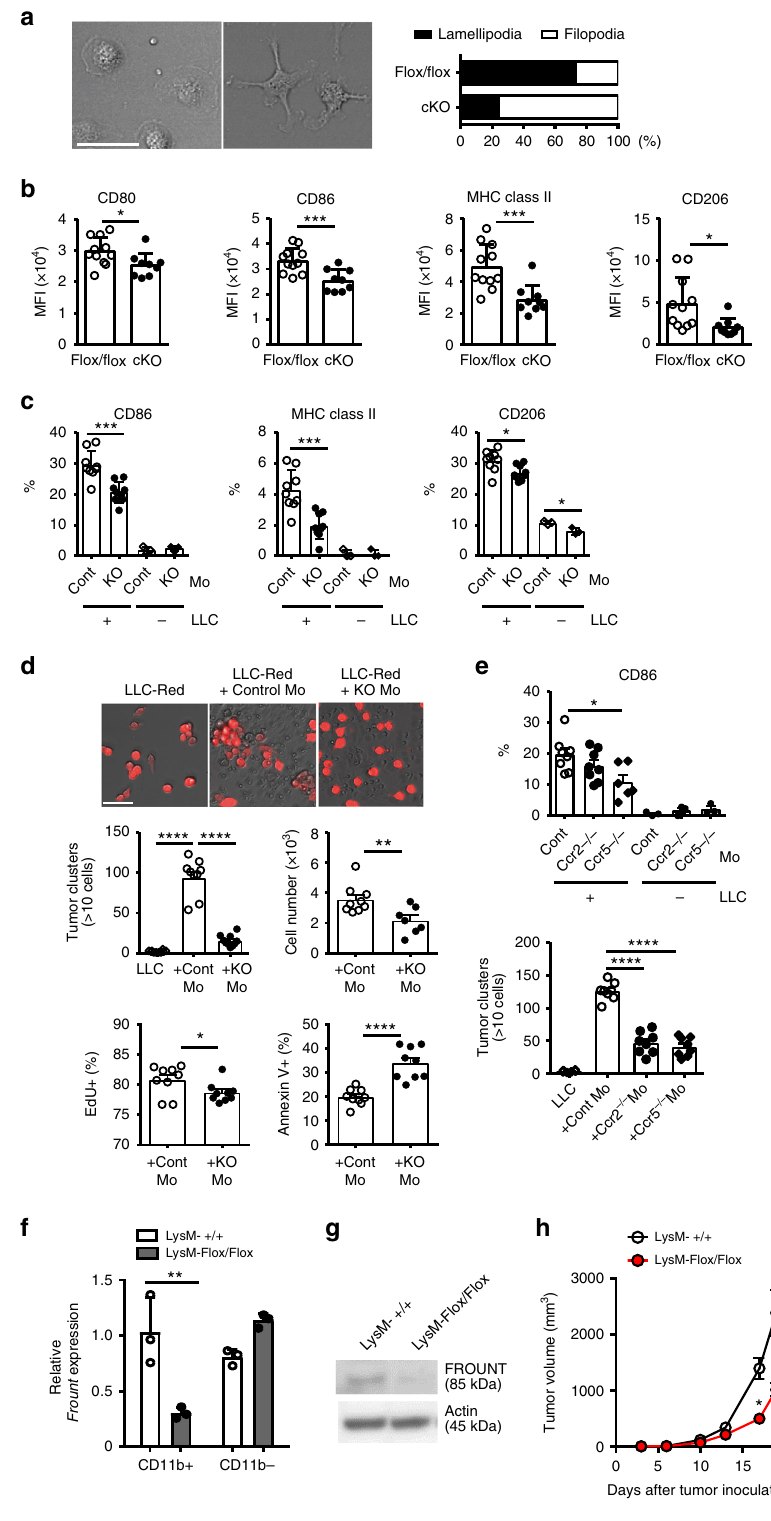
DSF administration signi fi cantly reduced lung metastatic nodule formation following intravenous injection of B16 or LLC tumor cells (Fig. 7a) and inhibited subcutaneous tumor growth (Fig. 7b) at a dose equivalent to the clinical dosage used to treat alcoholism. DSF treatment also reduced the number of tumor-associated monocytes/macrophages but not neutrophils, with a decreased ratio of M2 macrophages (Fig. 7c), and diminished